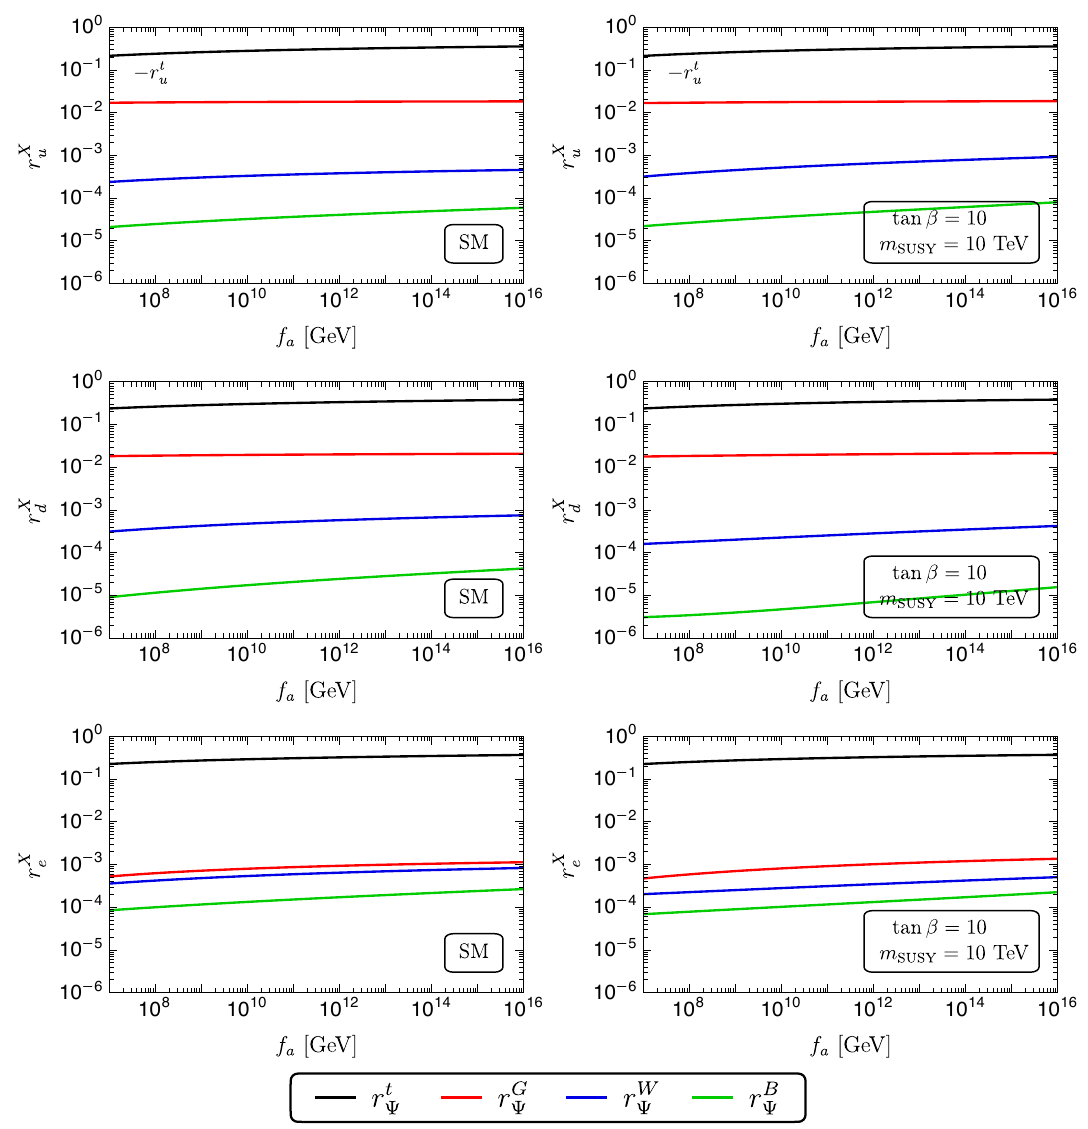
Figure 4 . Radiative corrections to the axion couplings to the light quarks and electron from { C t ( f a ) , ˜ c G ( f a ) , ˜ c W ( f a ) , ˜ c B ( f a ) } for the SM or from { n t ( f a ) , ˜ c G ( f a ) , ˜ c W ( f a ) , ˜ c B ( f a ) } for the MSSM: ∆ C Ψ = r t [ n t ( f a ) or C t ( f a )] + P r A ˜ c A ( f a ) . For the MSSM, we take the parameters Ψ Ψ A = G,W,B tan β = 10 and m SUSY = 10